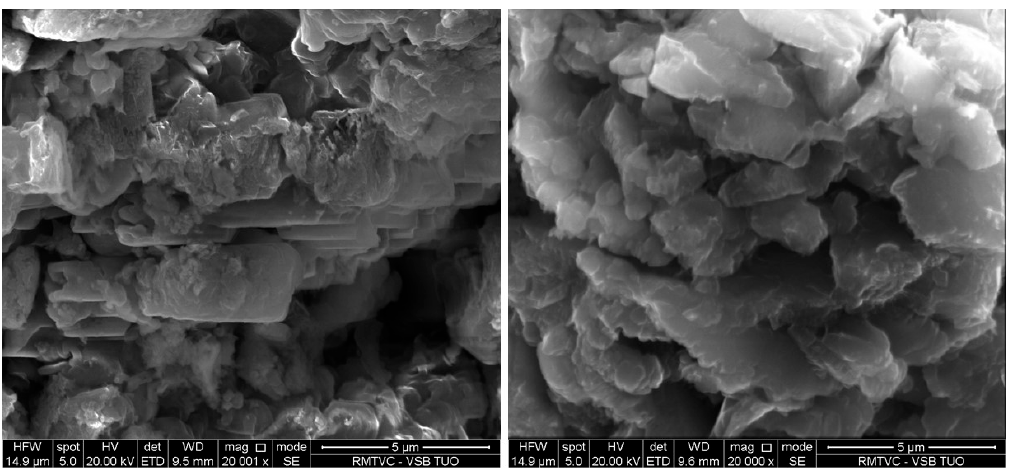
Figure 8. SEM images of bulk ( left ) and bulk 30 % H 2 O 2 nanomaterials ( right Figure 8 . SEM images of bulk ( left ) and bulk 30 % H 2 O 2 nanomaterials ( right ).